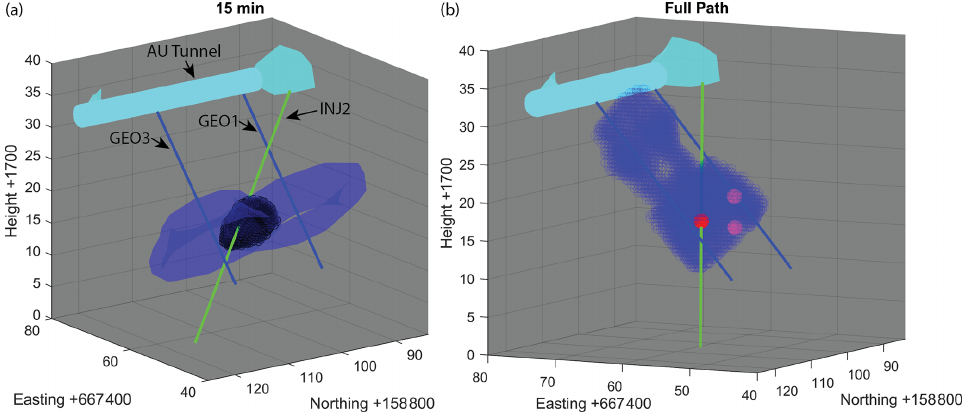
Figure 9. Tracer flow path reconstruction and important boreholes (GEO in blue, INJ2 in green). (a) Reflection tubes at 15min after tracer injection for both surveys in blue and their intersection in black. (b) Fully reconstructed flow path for all time steps. The injection interval is indicated by a red sphere; the two PRP breakthrough locations are indicated by purple